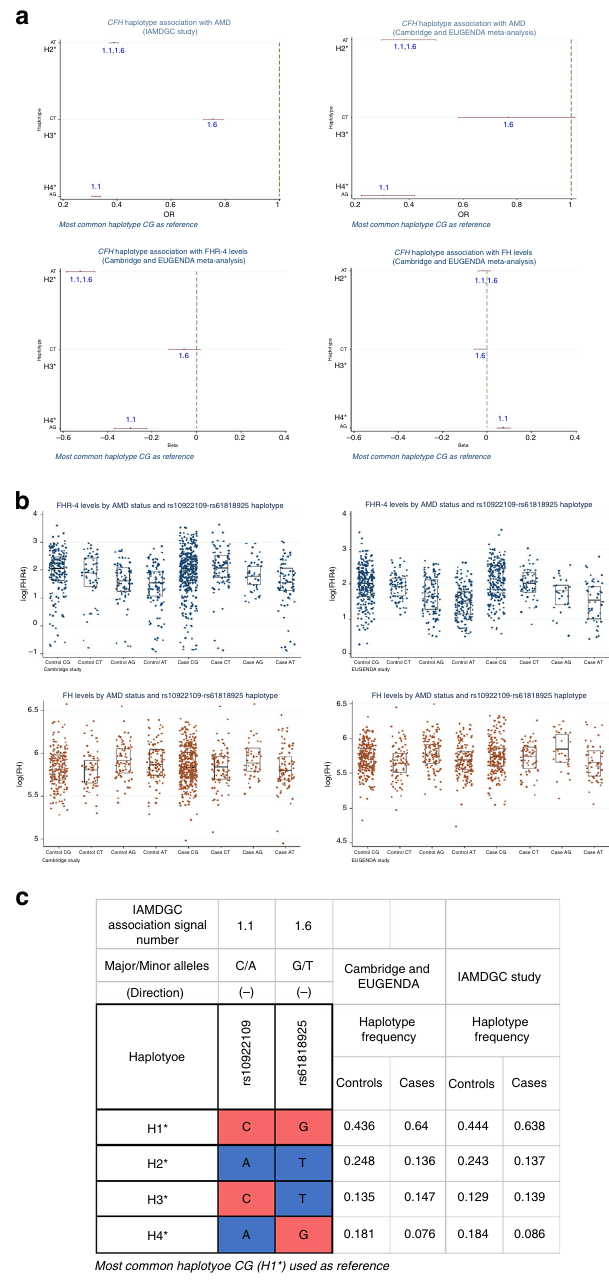
fi tted using a 1:1 Langmuir association/dissociation model (BIAevaluation 4.1; GE Healthcare).